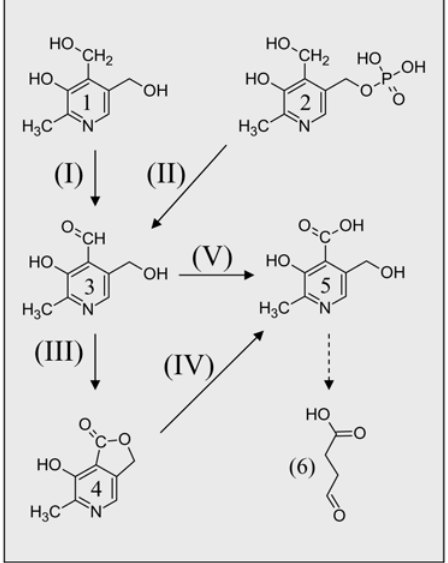
Figure 2. Bacterial catabolic pathways of vitB6. Roman numbers in parenthesis indicate enzymes: (I) pyridoxine 4-oxidase; (II) pyridoxal phosphatase; (III) pyridoxal 4- dehydrogenase; (IV) 4-pyridoxollactonase; (V) pyridoxol oxidase. Arabic numbers indicate compound: (1) PN; (2) PLP; (3) PL; (4) 4-pyridoxolactone; (5) 4-pyridoxic acid; (6) succinic semialdehyde (modified from